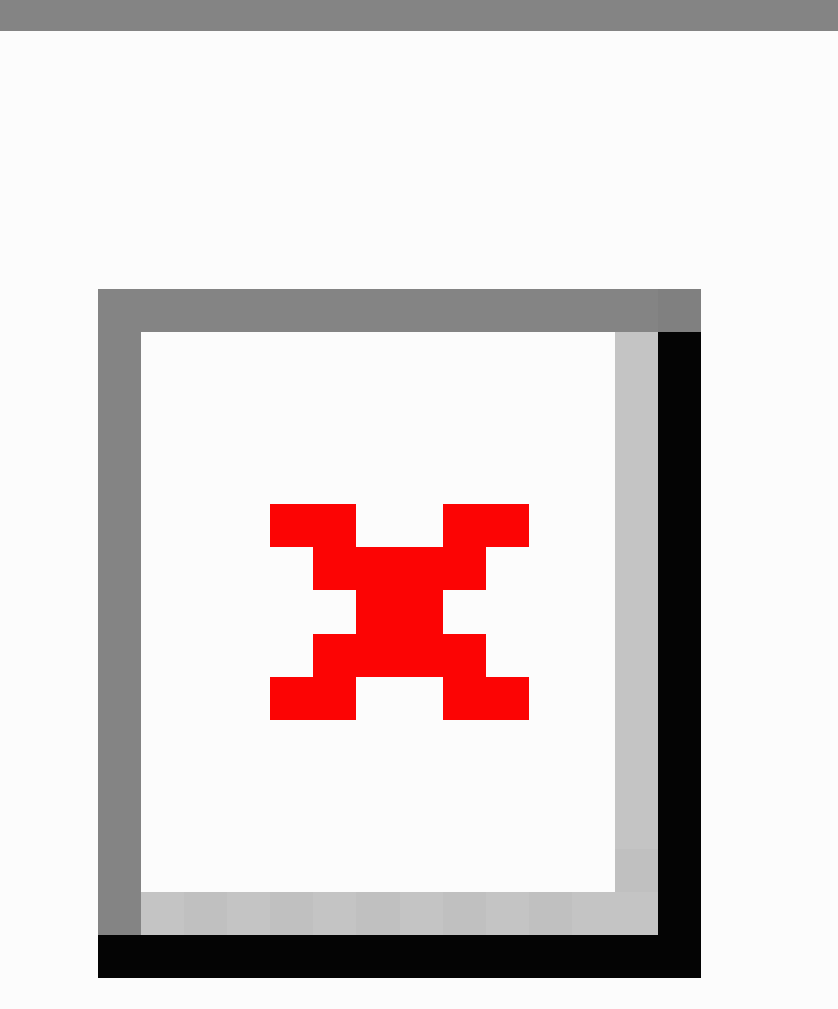
Figure 1. Top n-grams (n=1,2,3) with normalized prevalence that co-occur with the named side effects. Blue and red bars represent magnitude of normalized occurrence in the social media data of individuals showing the most and least improved symptomatic outcomes,